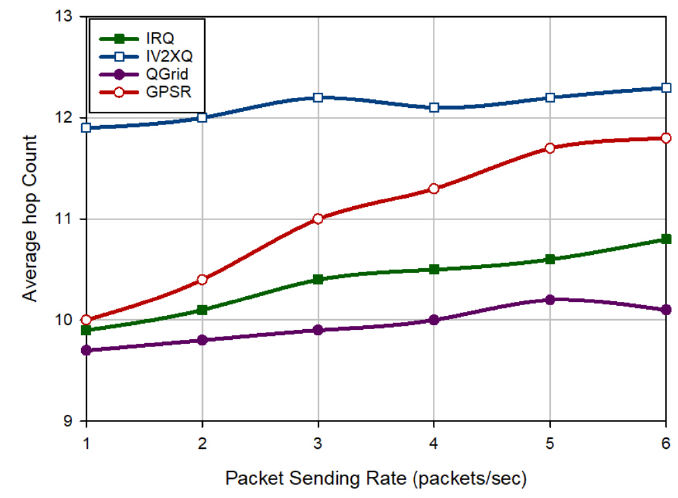
Figure 8. Comparison of the hop count in different routing methods based on the PSR.